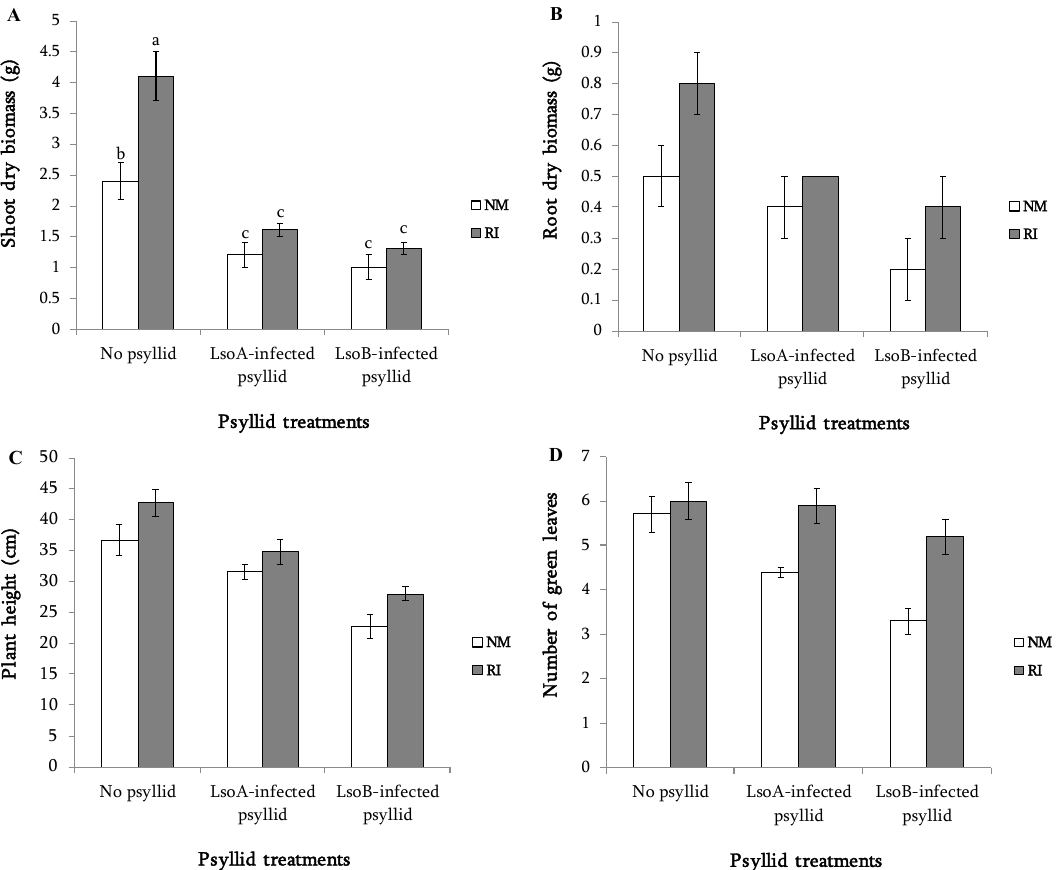
Figure 1. Influence of mycorrhization and Lso infection on tomato shoot dry weight ( A ), root dry weight ( B ), height ( C ), and number of leaves ( D ). NM: non-mycorrhized plants, RI: mycorrhized plants. Growth data are pooled across experiments. For shoot dry weight biomass there was a significant Lso treatment-by-mycorrhization treatment interaction effect, and bars marked with different letters are significantly different ( p < 0.05) according to multiple comparisons using Student’s t test. For all other variables, there were significant mycorrhization treatment and Lso treatment main effects ( p < 0.05). Multiple comparisons ( p < 0.05) were used to test for differences among Lso treatments. Results were as follows: RI > NM, root dry weight: no-psyllid ≥ LsoA ≥ LsoB, plant height: no-psyllid = LsoA > LsoB, leaf number: no-psyllid > LsoA > LsoB.